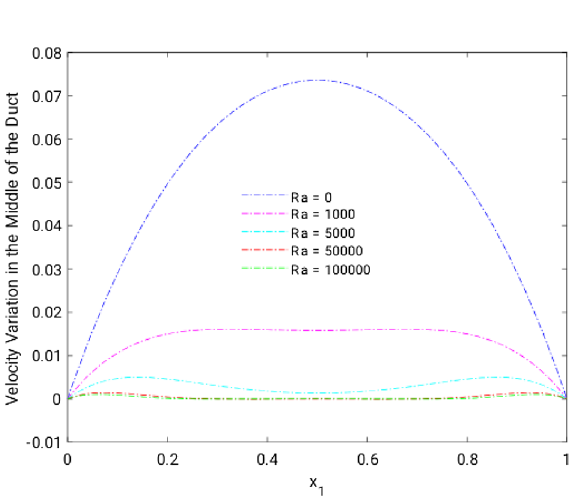
Figure 8. Velocity variation along the line x 2 = 0.5 for altered Ra, in the absence of external MF.